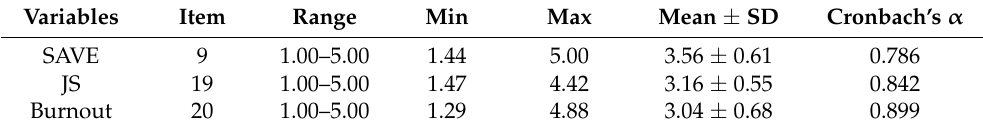
Table 2. Descriptive statistics for SAVE, job stress, and burnout of dental hygienists.